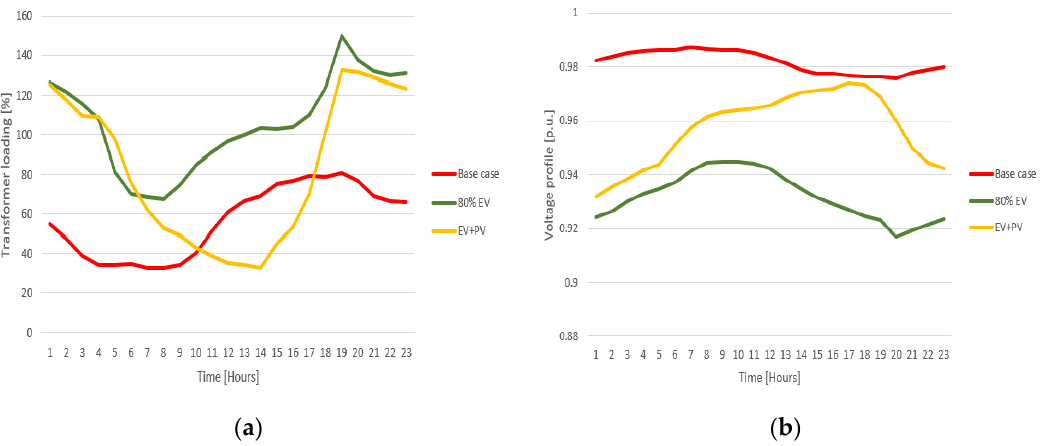
Figure 11. Comparison of urban ( a ) transformer loadings and ( b ) most loaded feeder voltage profiles with 80% EV penetration.